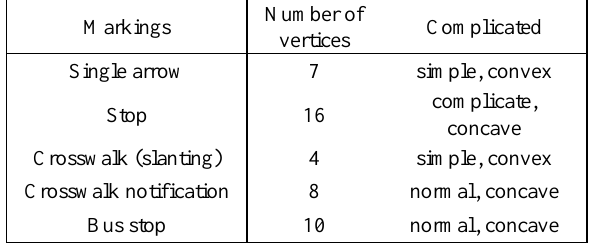
Table 3. Target objects information